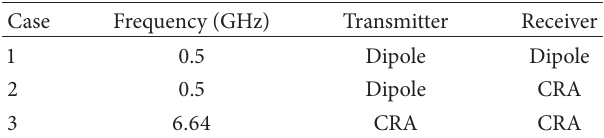
Figure 17: Directivity of the CRA for the third iteration at a frequency of 8.5